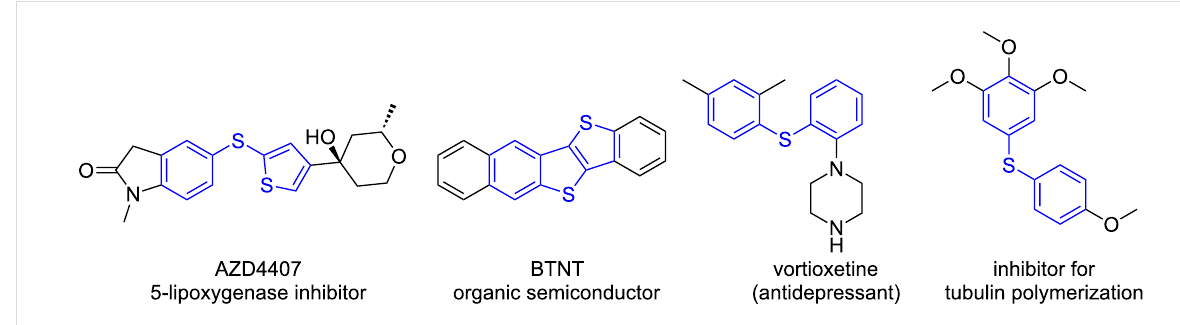
Figure 1: Selected examples of sulfenylated heterocycles used in pharmaceuticals and material chemistry.